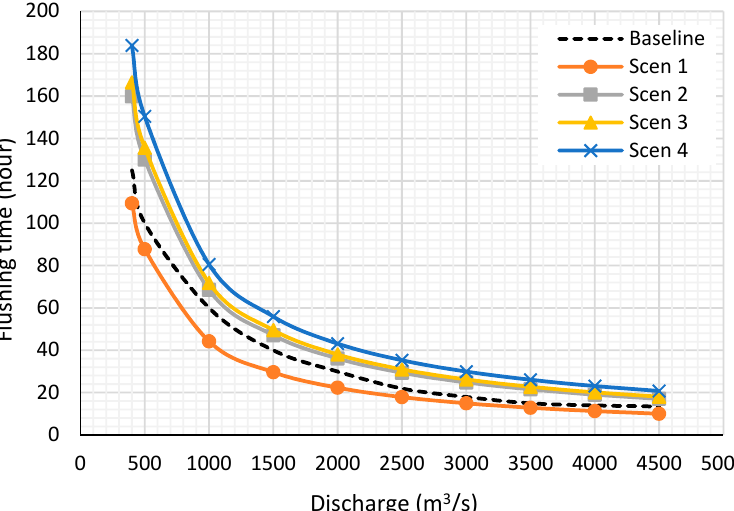
Figure 13. Estimated flushing time under varying discharge levels (Q, m 3 /s) for four scenarios.